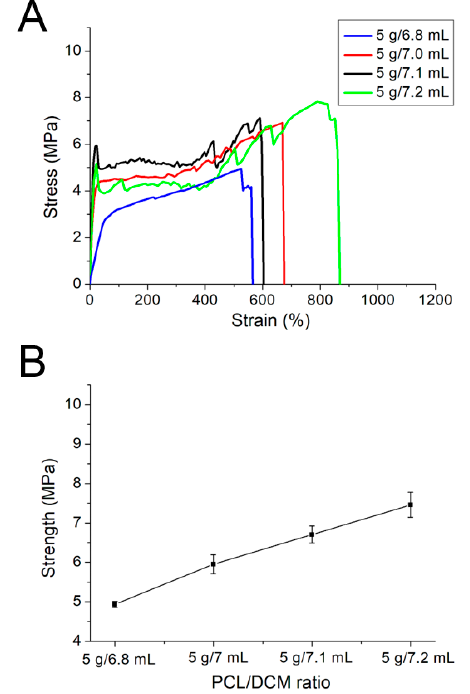
Figure 5. E ff ect of the PCL / DCM ratio on the mechanical properties of additively manufactured PCL Figure 5. Effect of the PCL/DCM ratio on the mechanical properties of additively manufactured PCL parts (( A ): stress strain curves; ( B ): maximum tensile strengths, other parameters used were those of parts (A: stress strain curves; B: maximum tensile strengths, other parameters used were those of Level 2 in Table Level 2 in Table 1).